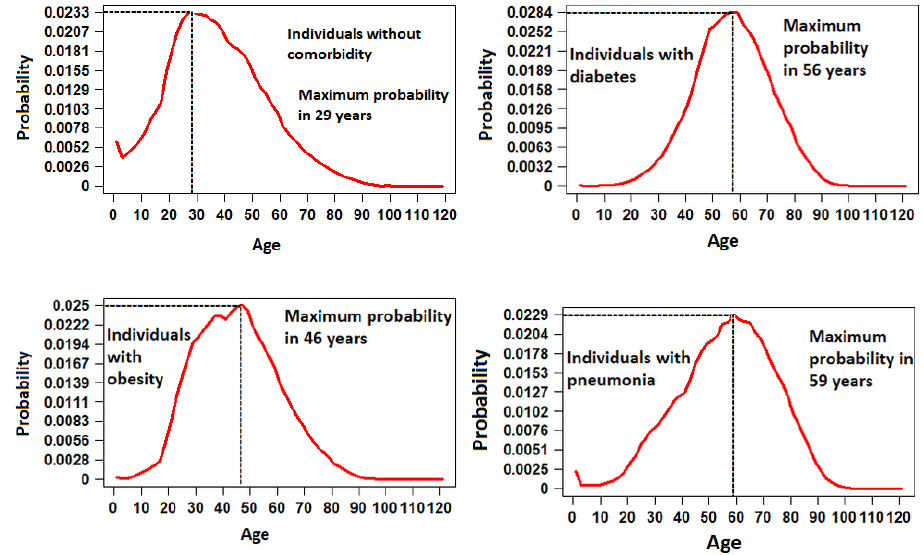
Figure 7. Probability distribution functions for positive COVID-19 cases by comorbidity against age.